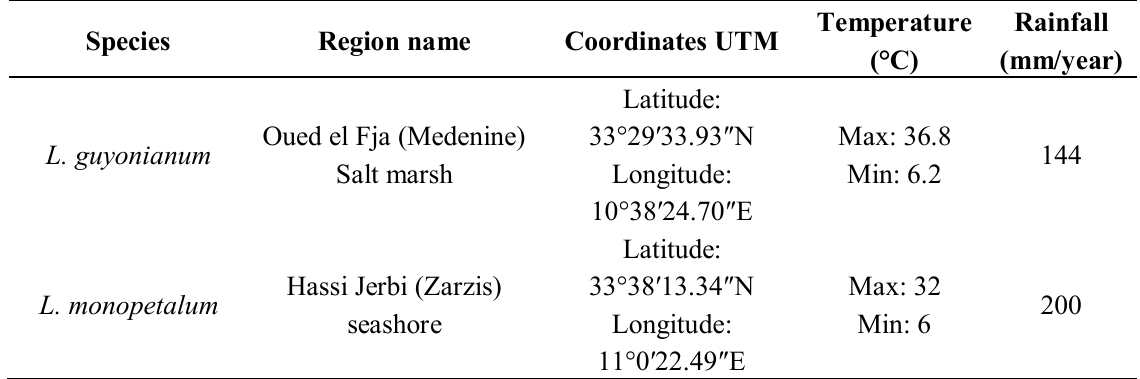
Table 1. Main characteristics of harvest